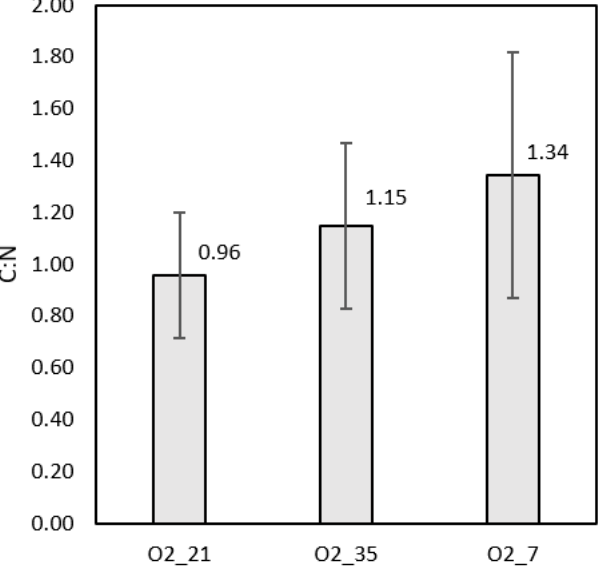
Figure 7. The C:N ratios at each condition were between 1–2. Differences between conditions could be attributed to varying malic acid concentrations and ETC down-regulation, which would increase carbon dioxide formation. The error bars indicated the standard deviations of each set of